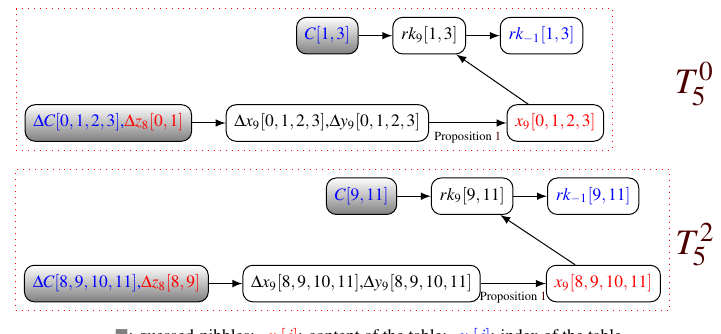
and Table T 2 on the 10-round attack. There is one value for 5 5